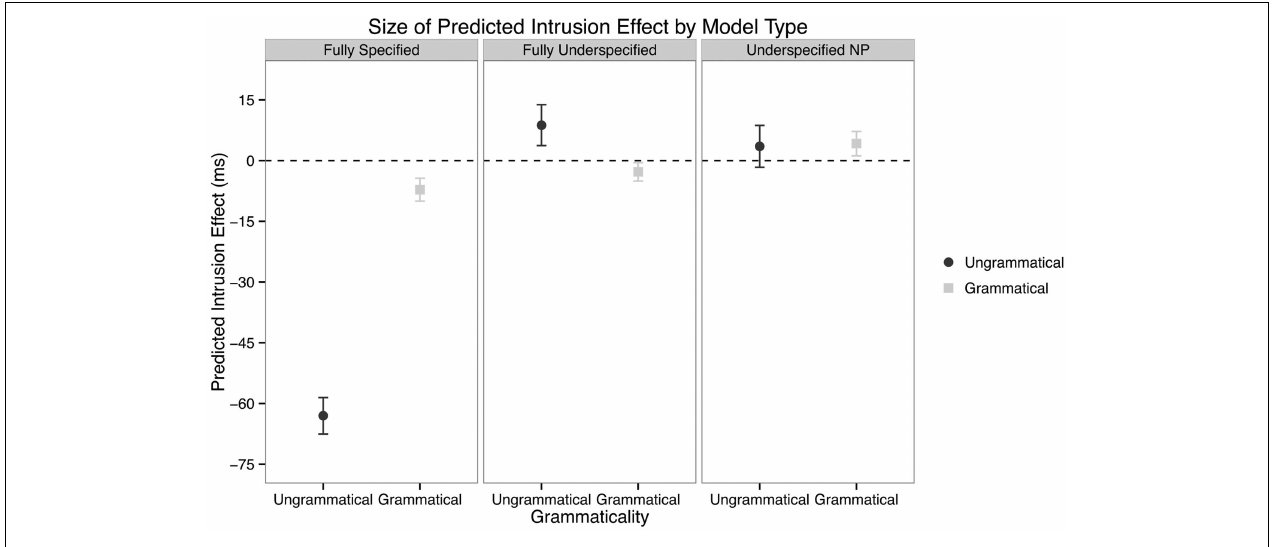
FIGURE 8 | Predicted sizes of intrusion effects for three different ACT-R models. Intrusion effects are computed by subtracting retrieval times in plural attractor conditions from times in singular attractor conditions. Error bars represent the standard error of the mean of